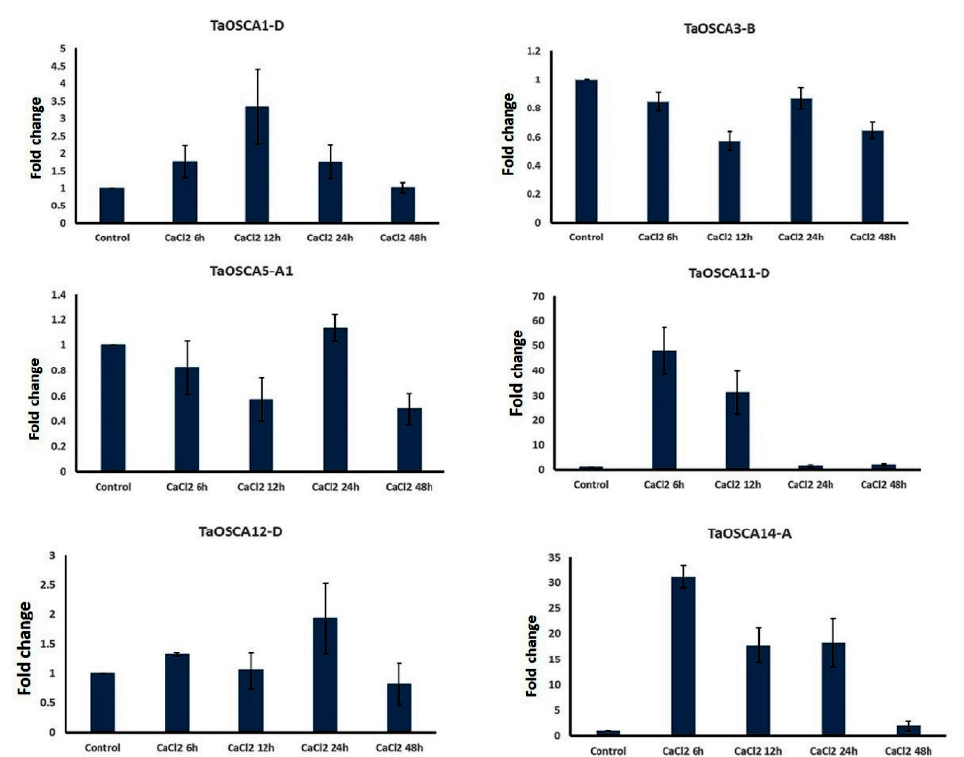
Figure 5. qRT-PCR analysis. Expression analysis of six TaOSCA genes was performed using qRT-PCR. Bar graphs show the expression trends of selected genes at 6, 12, 24, and 48 h of CaCl 2 treatment. The bar graphs represent the fold change of each gene expression and the vertical lines indicate the standard deviation.